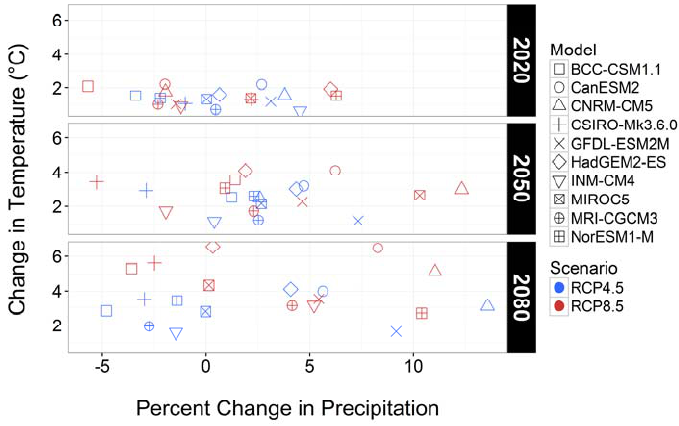
Figure 3. Change of temperature and annual percent change in precipitation in comparison to historical conditions for all GCMs.